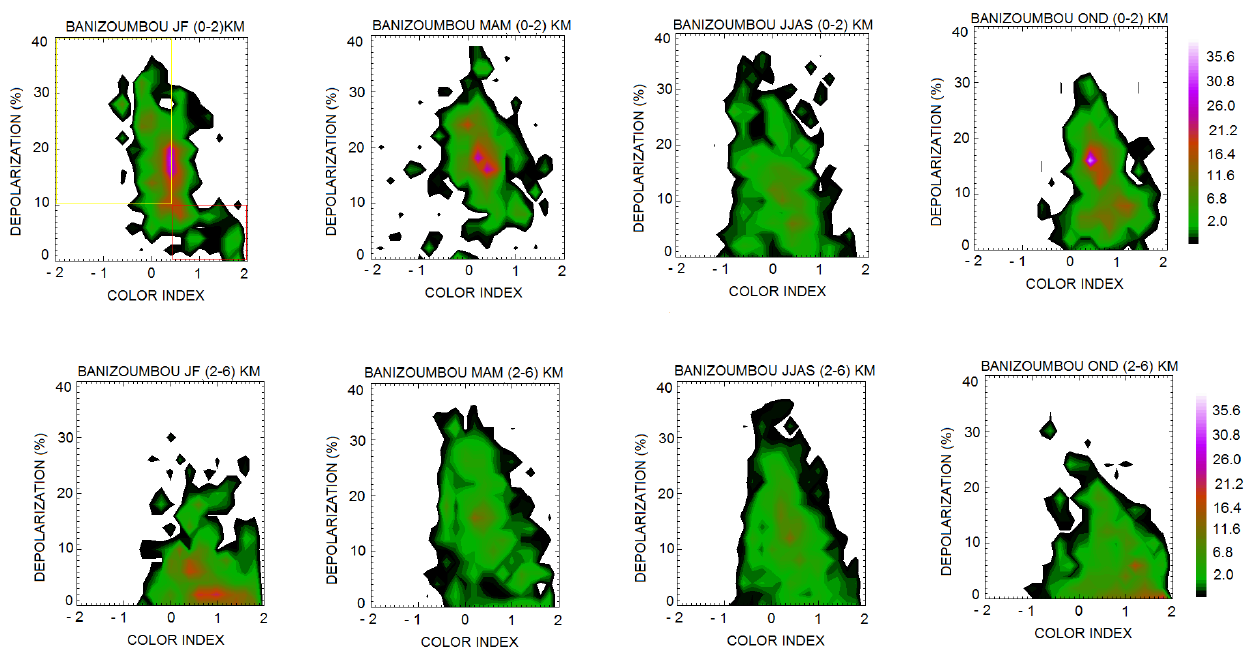
Fig. 4. Joint PDF for Color Index and Depolarization retrieved from CALIOP observations for different seasons over Banizoumbou site. In column 1 we depicted JF, in column 2 MAM, in column 3 JJAS, and in column 4 OND. Upper row show results for a boundary layer (0-2 km) and lower for free troposphere (2-6 km). In the upper left subplot yellow and red rectangles identify, respectively, desert dust and biomass burning aerosols classified using criteria specified in Table 4. Colored rectangles are shown only in one subplot for brevity.